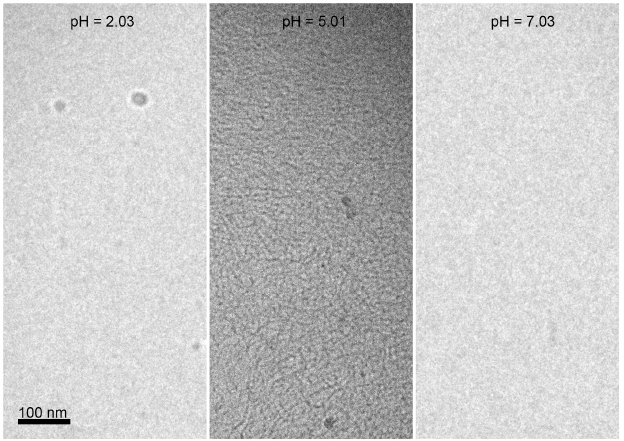
Figure 6. Cryo-TEM micrographs of nanostructured fluid based on 80 mM C 16 MPBr-AA aqueous solution at different pH conditions.